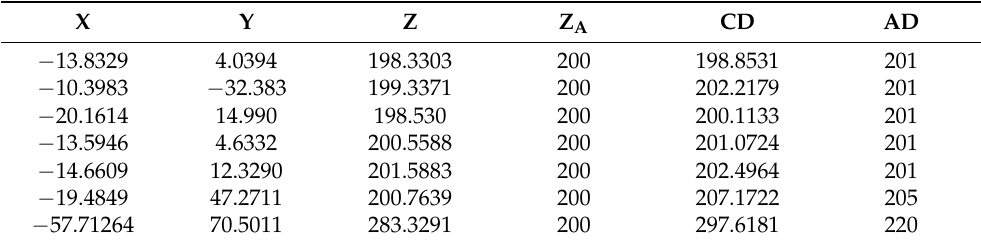
Table 3. Binocular camera range results (unit: mm) under (1st, . . . , 6th rows) random change in light in normal range and (7th row) an overexposure condition.